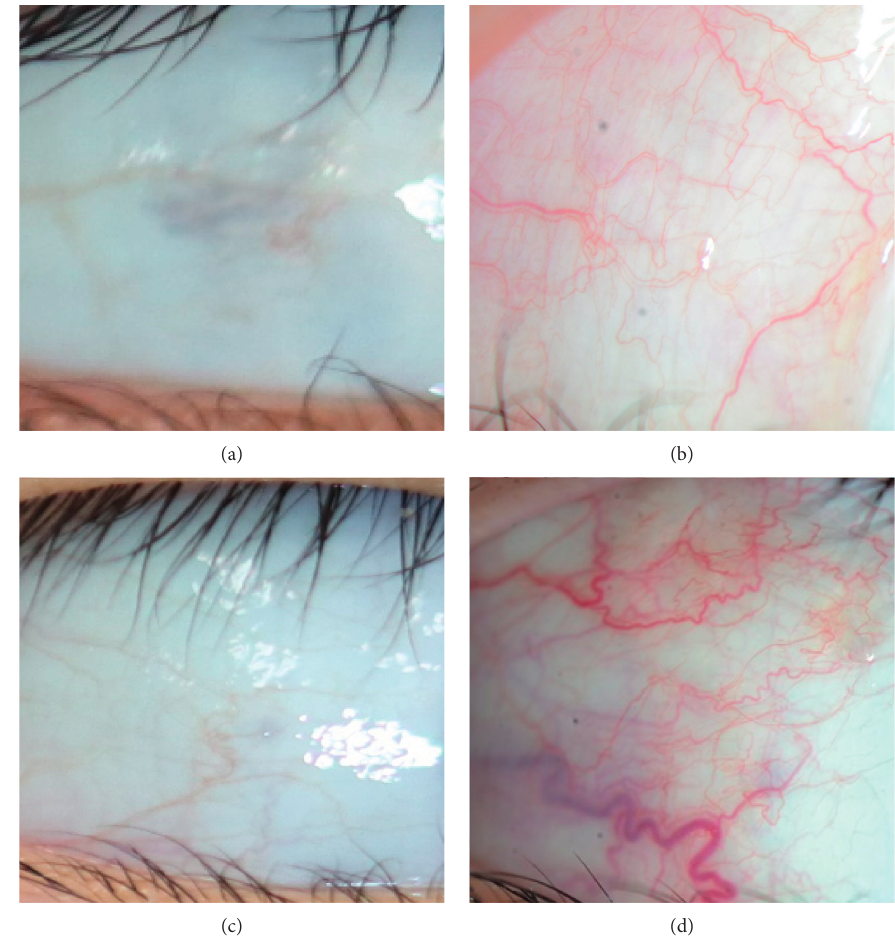
Figure 1: Anterior segment photographs of conjunctival injection before and after strabismus surgery in the brimonidine group ((a), (b)) and control group ((c), (d)). Conjunctival injection increased after strabismus surgery in both groups, while the amount of increase was less in the brimonidine group. Based on the preoperative conjunctival injection score, (b) scored 6.4 and (d) scored 33.3. Table 1: Baseline characteristics of patients receiving topical brimonidine 0.15% and the control group.